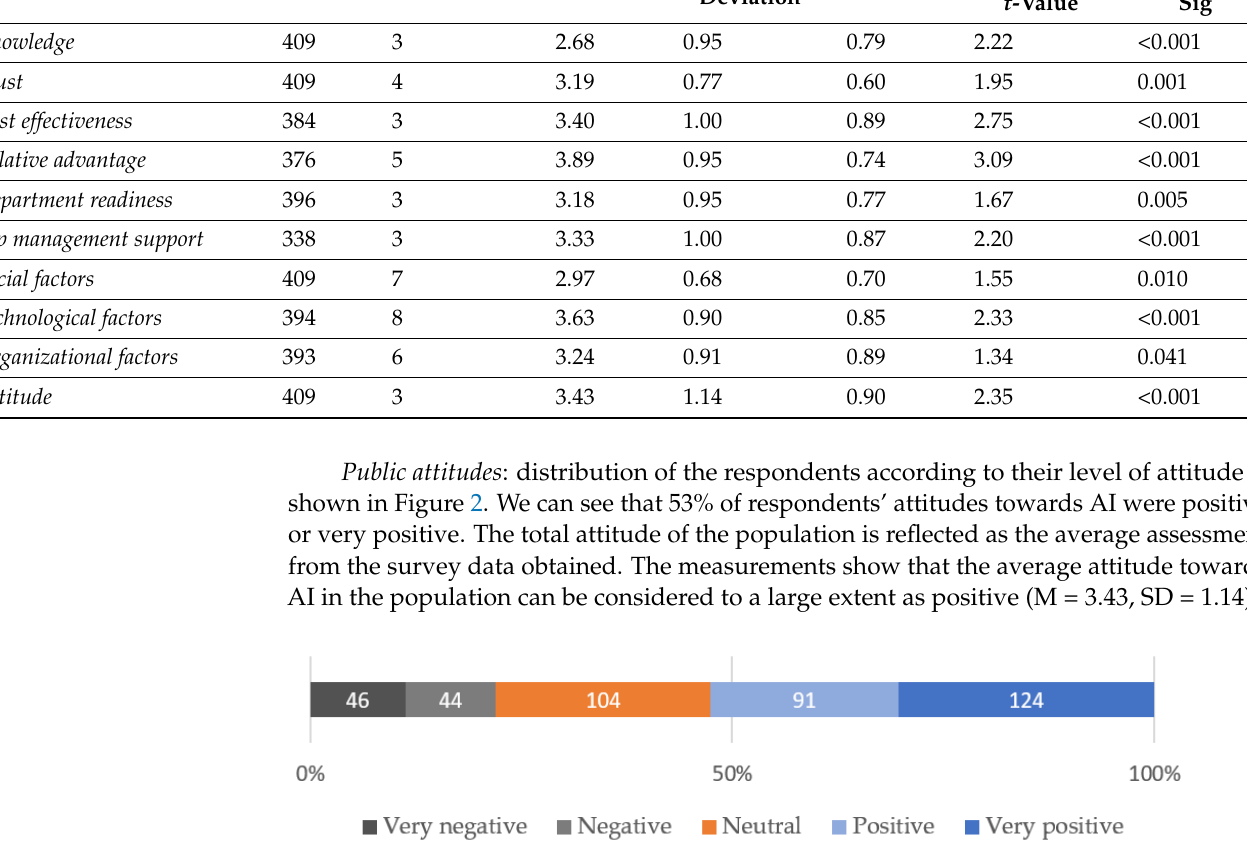
Figure 4. Average attitude towards AI according to industry.